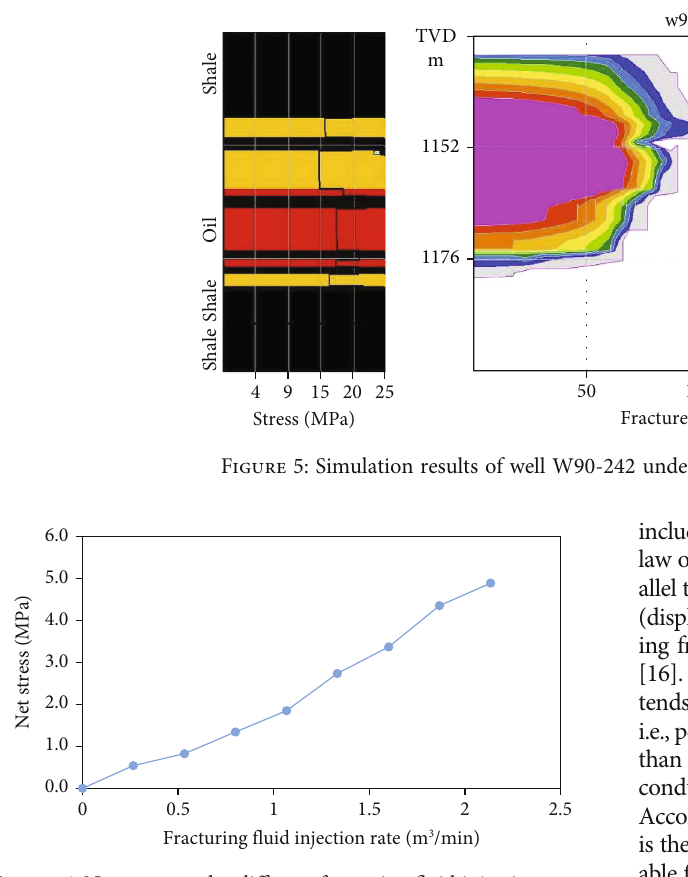
Figure 6: Net stress under di ff erent fracturing fl uid injection